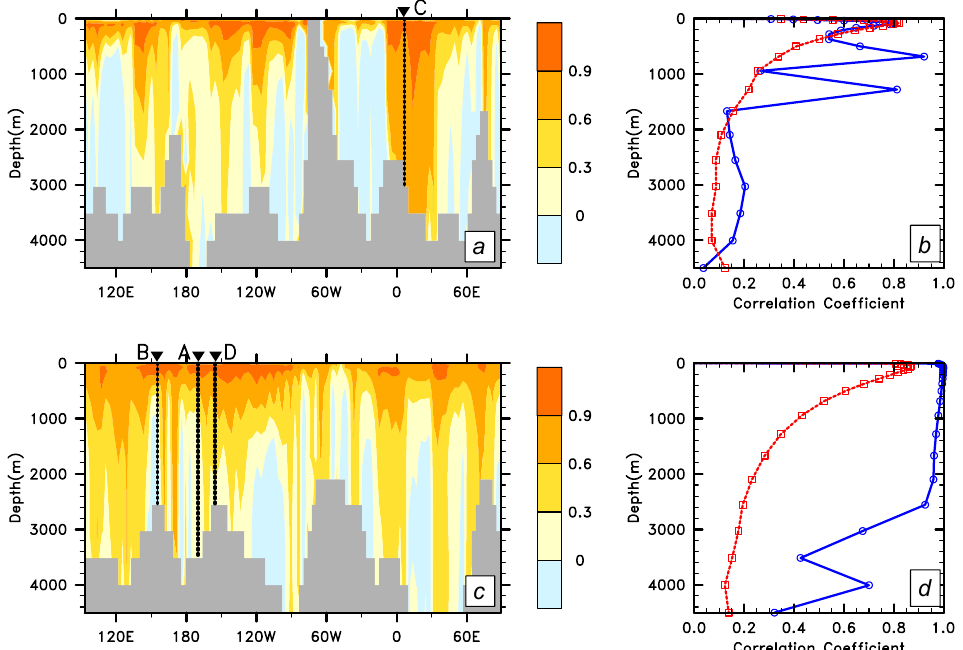
Figure 5. Depth–longitude diagrams of local correlation between the Ekman pumping and local vertical velocity ( a ) outside the open channel region, along 52.9 ◦ S and ( c ) within the open channel region, along the average section between 60.9 ◦ S and 57.1 ◦ S. Locations of the proxy cores A–D are marked. Vertical profiles of the correlation between zonal mean Ekman pumping and zonal mean vertical velocity (blue) and the zonal average of the correlation between local Ekman pumping and local vertical velocity (red) along the latitude of ( b ) 52.9 ◦ S and ( d ) the average section between 60.9 ◦ S and 57.1 ◦